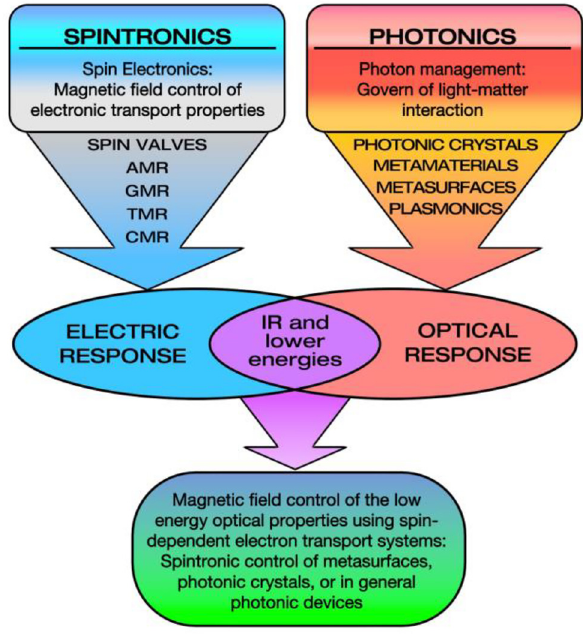
Figure 1: Common room for Spintronics and Photonics. These two disciplines overlap in the low frequency range of the electromagnetic spectrum in which both, electrical conductivity and optical properties, rely on conduction electrons and are connected by the Magneto Refractive